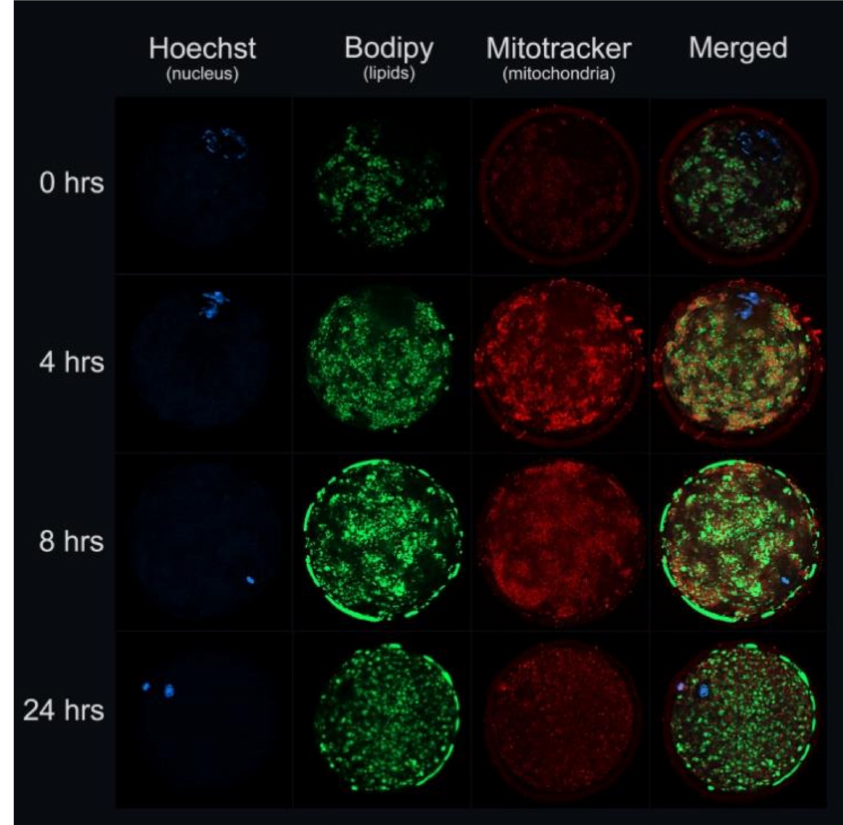
Figure 1. Illustrative images of bovine oocytes during in vitro maturation (0, 4, 8, and 24 h of matura- tion) demonstrating meiotic maturation (nucleus configuration, Hoechst 33,342-blue; Sigma-Aldrich, Merck KgaA, Darmstadt, Germany), lipid content (Bodipy 493/503-green, Molecular Probes, Eugene, OR, EUA), and mitochondrial activity (MitoTracker ® Orange-red, Molecular Probes, Eugene, OR, EUA) (vital staining, confocal laser scanning microscopy, Cardoso/Pöhland/Melo-Sterza,